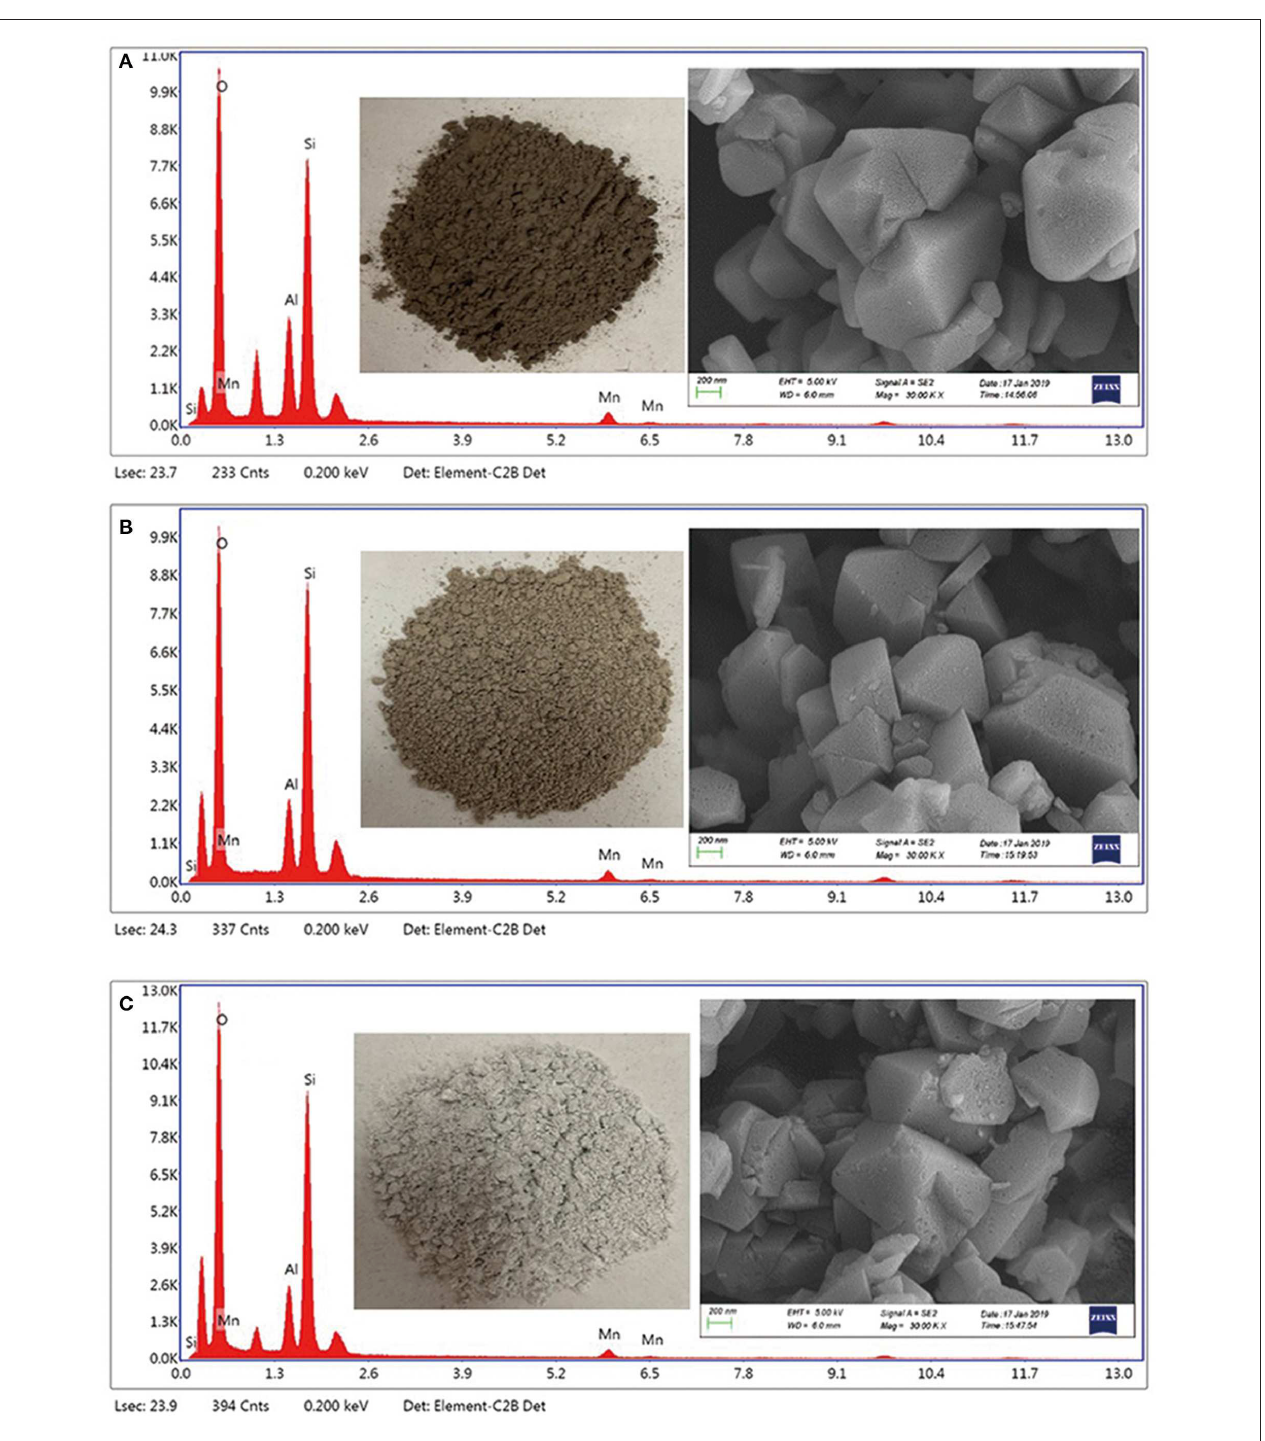
FIGURE 2 | SEM images-EDX spectra of Mn/NaY (A) , Mn/USY (B) , and Mn-USY (C) .